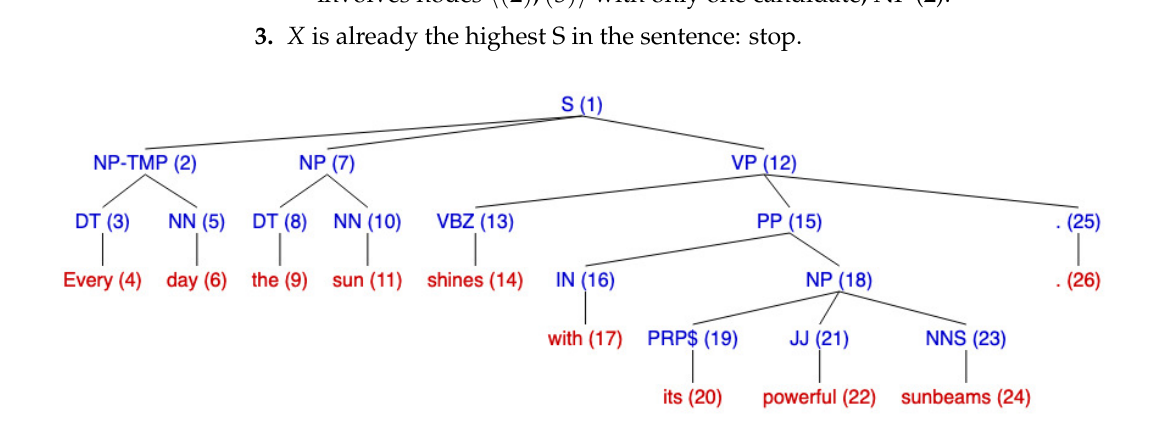
Figure 6. Sample text with possessive